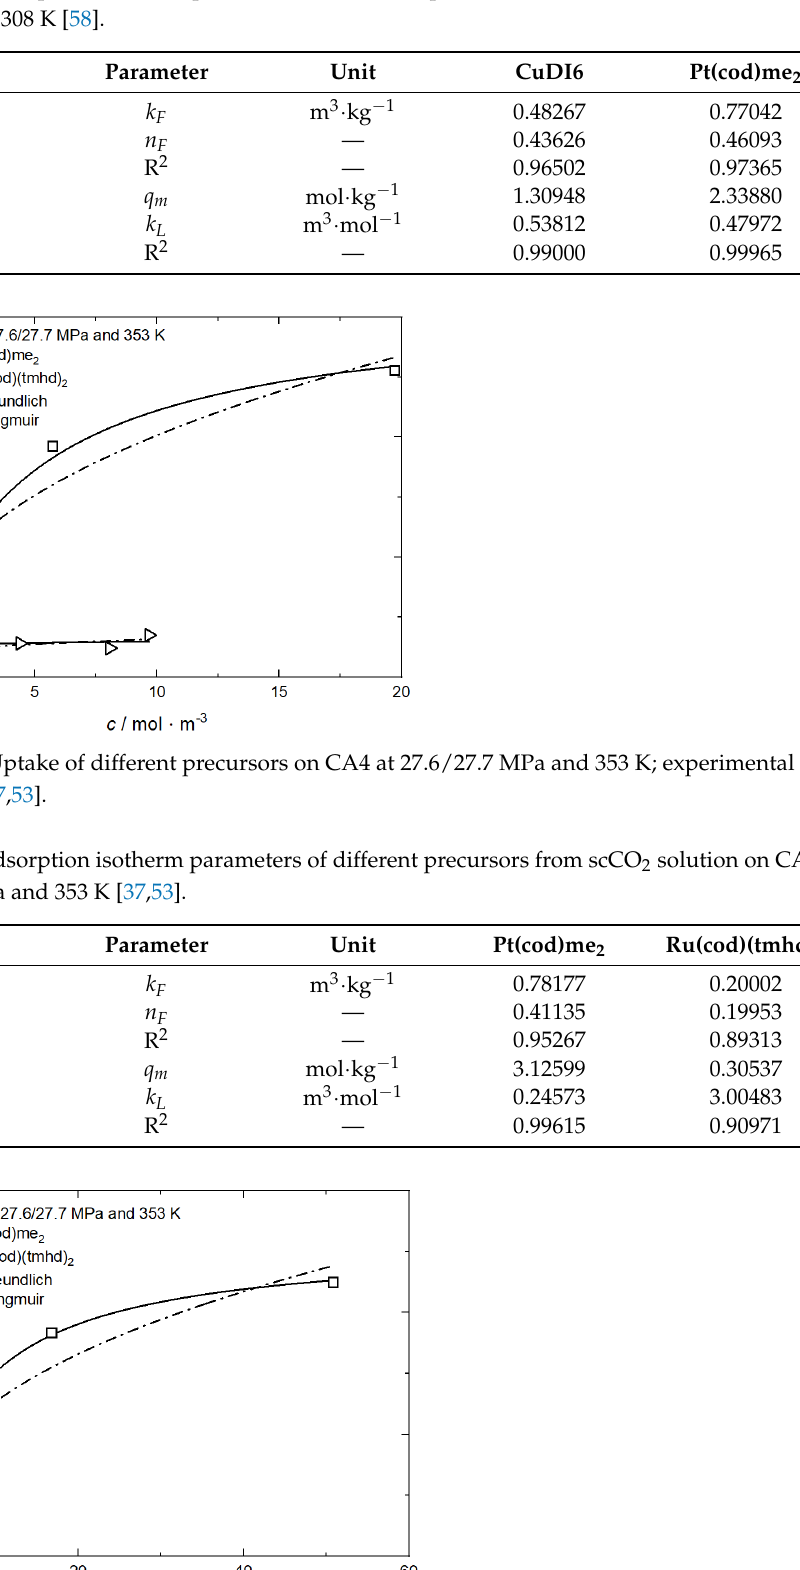
Table A17. Adsorption isotherm parameters of different precursors from scCO 2 solution on CA at